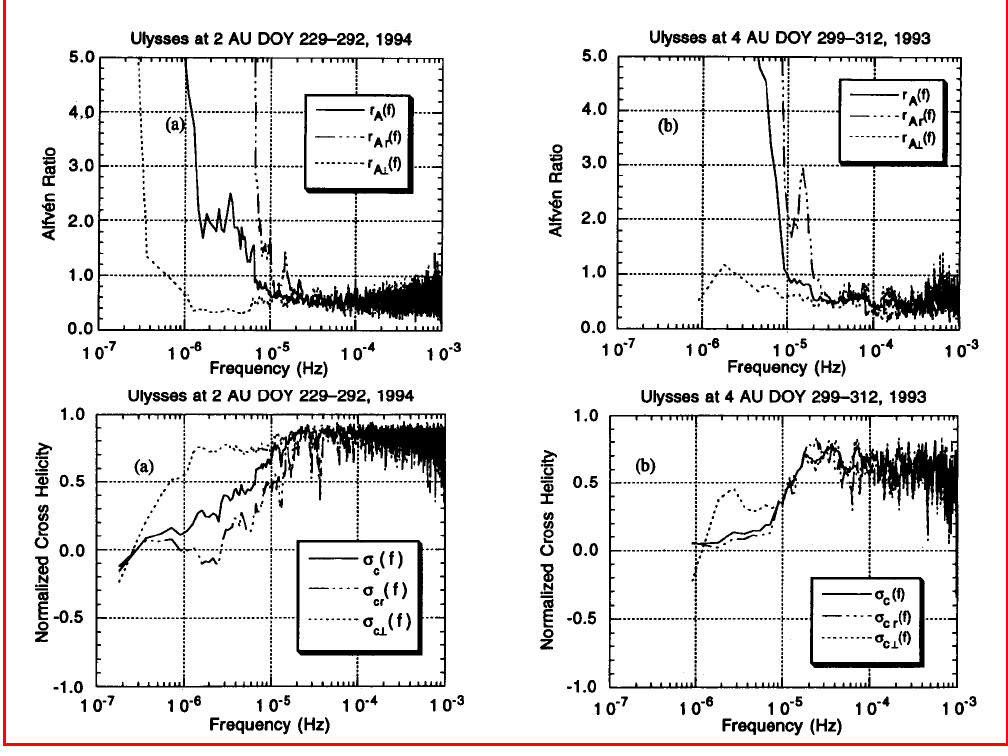
Figure 62: Normalized cross-helicity and Alfv´en ratio at 2 and 4 AU, as observed by Ulysses at − 80 ∘ and − 40 ∘ latitude, respectively. Image reproduced by permission from Goldstein et al. (1995a), copyright by